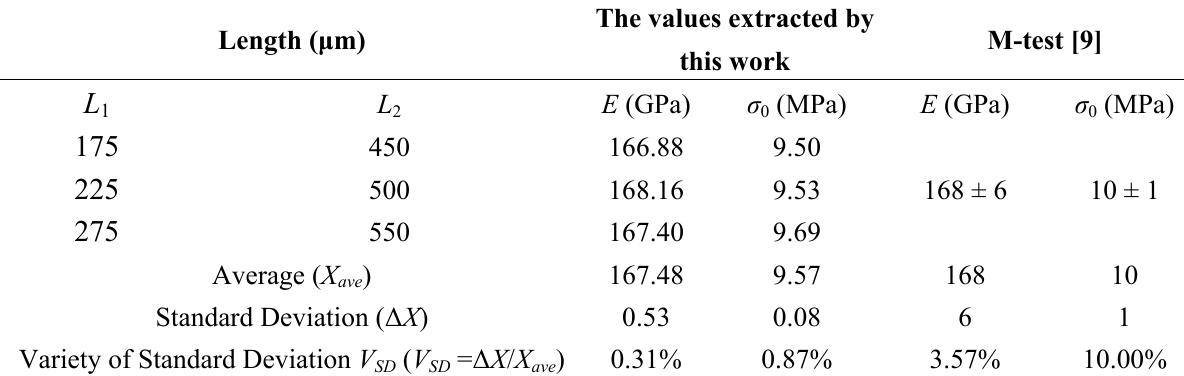
Table 4. Extracted Young’s modulus and mean stress of the mono-crystalline silicon in (110) crystalline plane and the comparison with Osterberg’s work